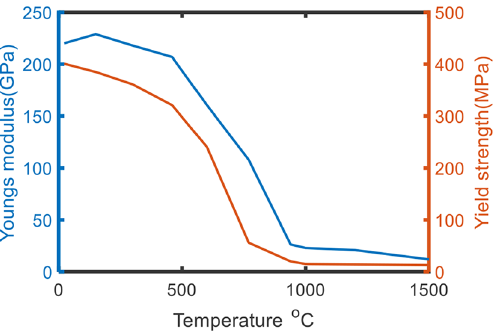
Fig. 2. The mechanical properties of low carbon steel as a function of temperature.